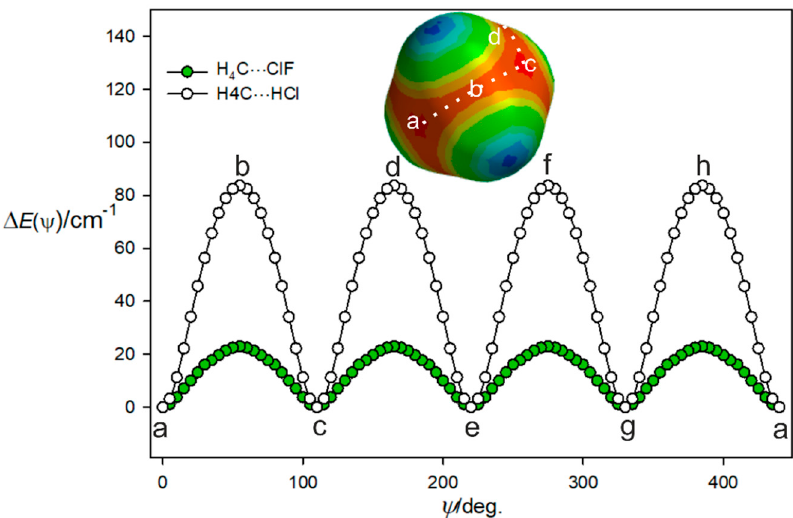
Figure 3. Variation of the energy of H 4 C ··· ClF with the angular orientation ψ of the two subunits that follows the lowest energy path a, b, c, etc. between the four equivalent minima. See the text for a definition of the angle ψ .